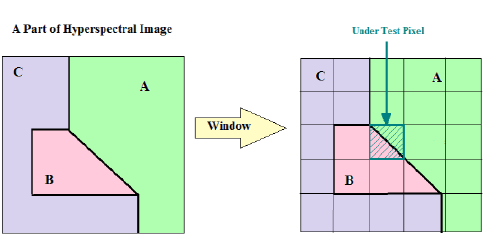
Figure 1. A schematic image of a part of hyperspectral data set in a 5×5 window including three